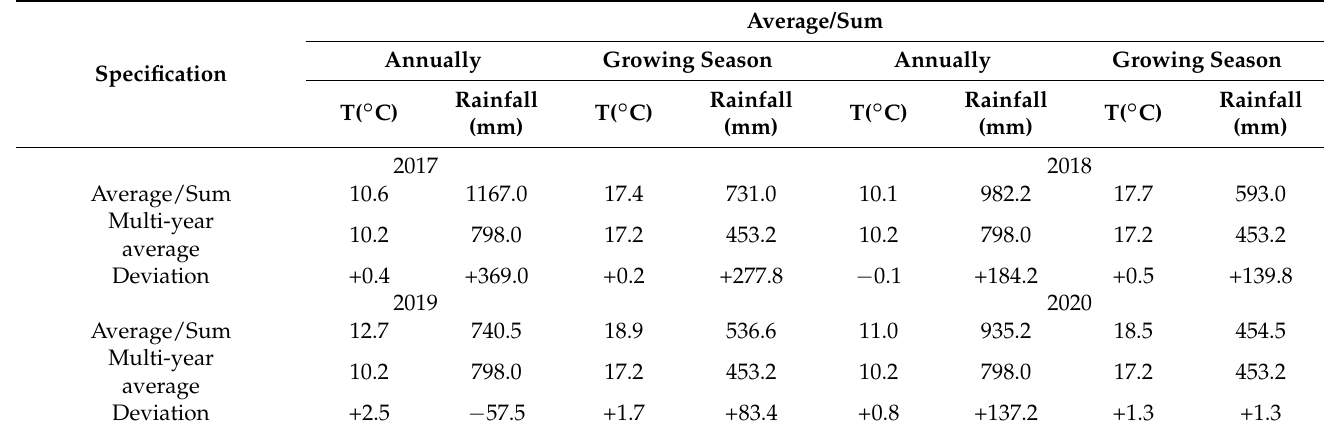
Table 1. The thermal and pluviometry regime of the